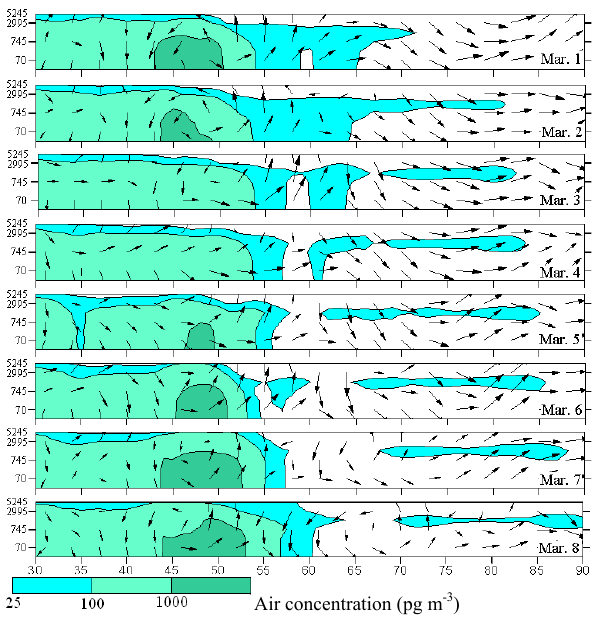
Fig. 8. Same as Fig. 3 for 1–8 March 1999 and the region of